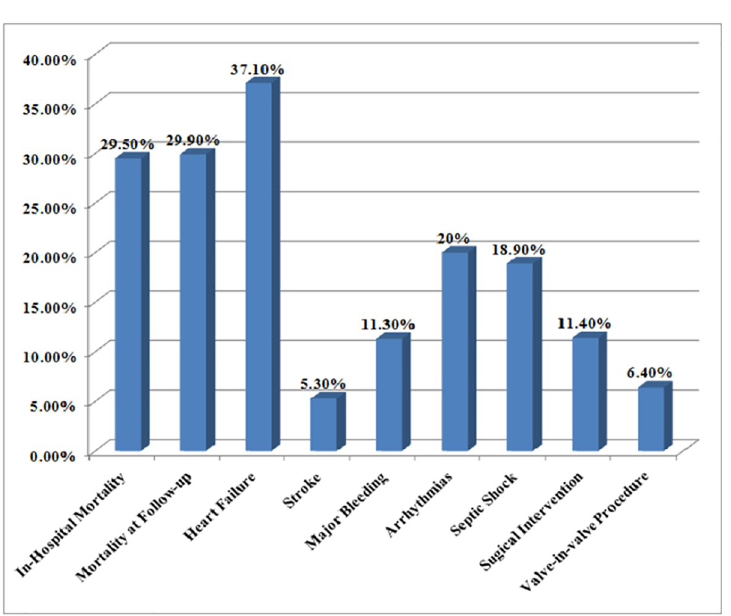
Fig 6. Clinical outcomes in patients of post-TAVI infective endocarditis. The incidence of infective endocarditis in the included studies with its causative organisms are summarized in Table